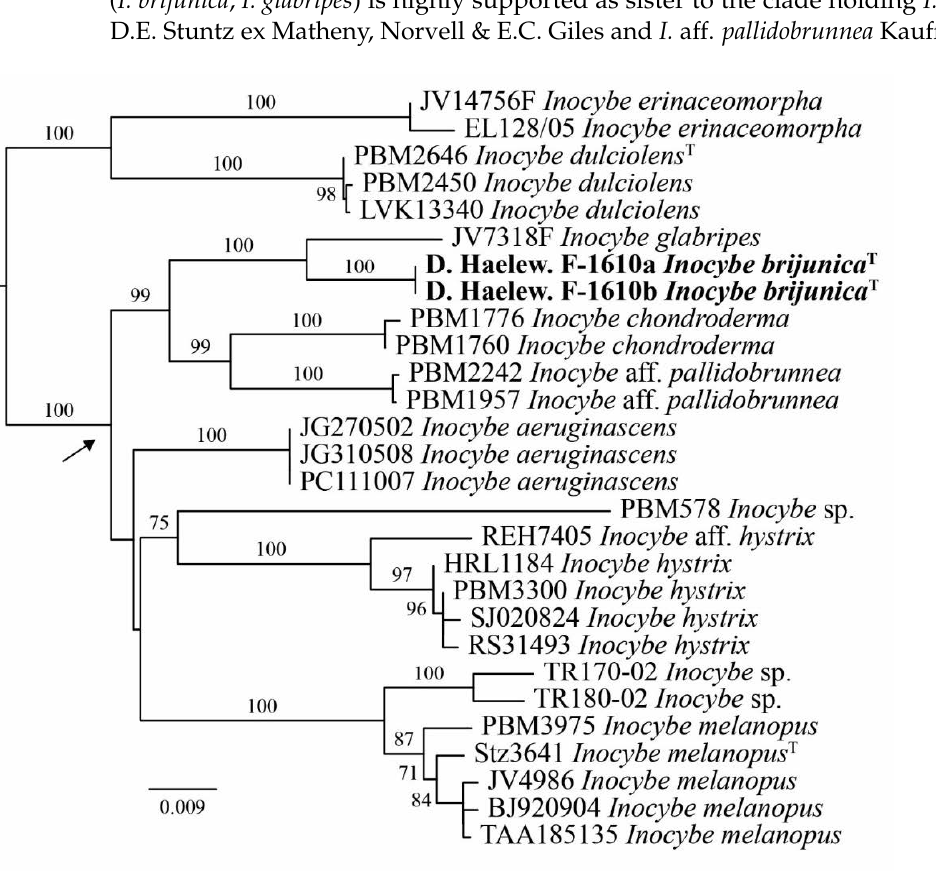
Figure 1. The best-scoring ML tree (-lnL = 8722.045120) of Inocybe sect. Hysterices (represented by the arrow) reconstructed from a concatenated ITS–nrLSU– rpb2 dataset of 28 isolates. The tree topology is the result of ML inference performed in IQ-TREE. For each node, the ML bootstrap ( ≥ 70) is presented above or in front of the branch leading to that node. The new species is in boldface. T stands for type